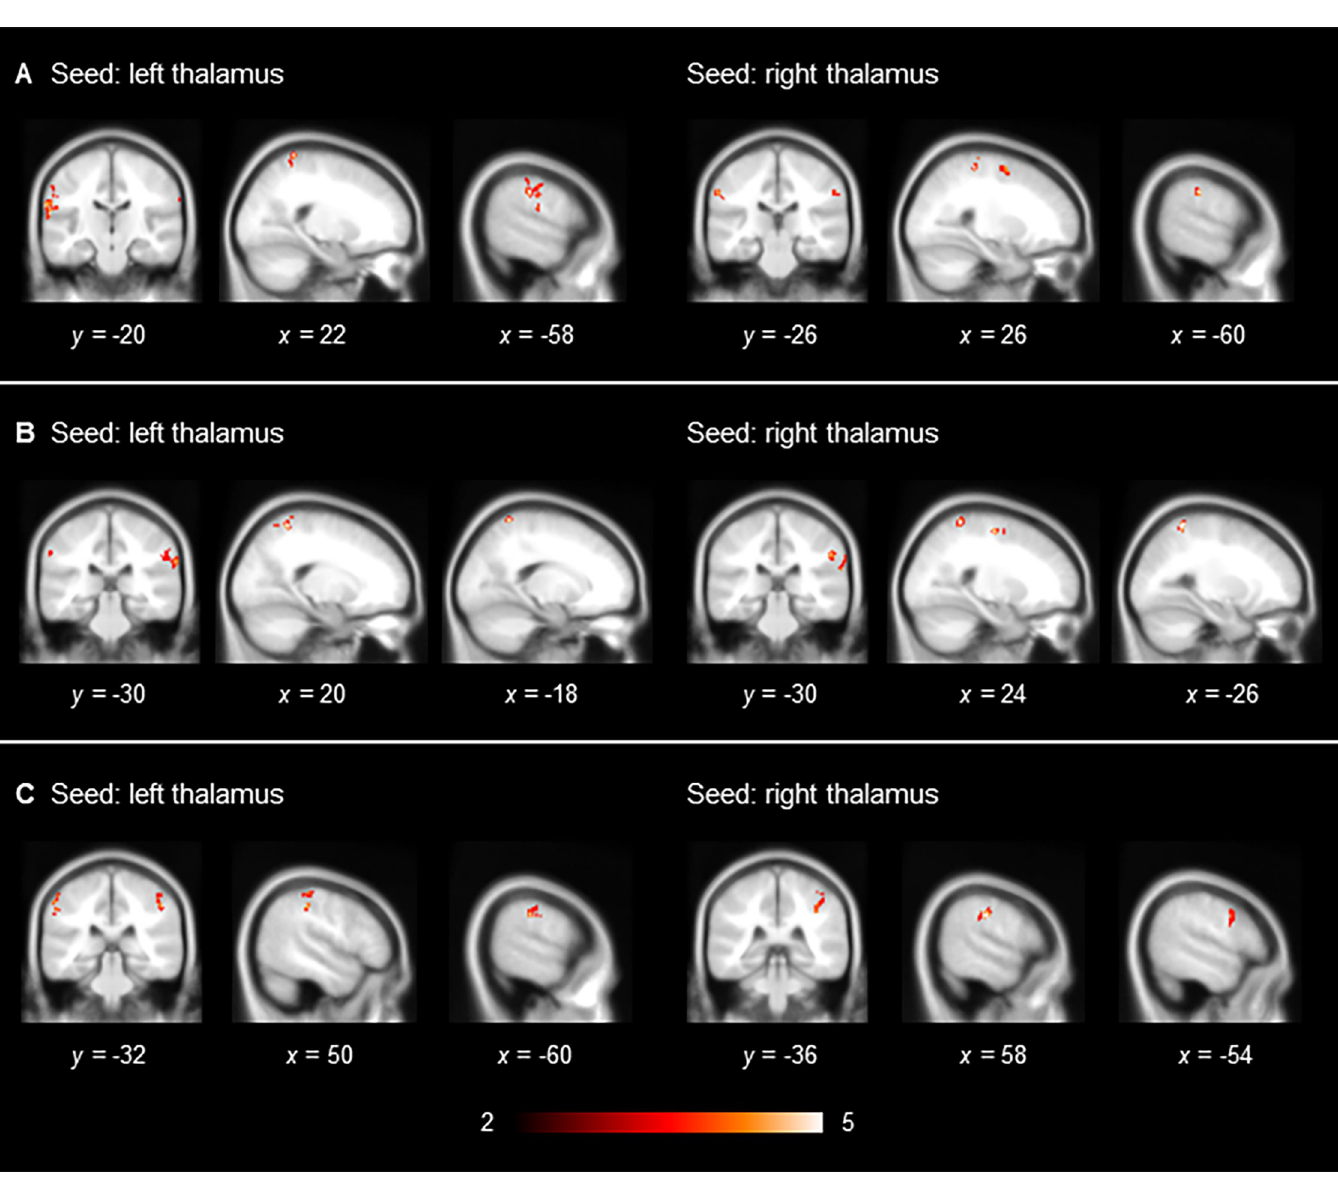
Fig 1. Significant increase in thalamic functional connectivity in adult cannabis non-users with a childhood diagnosis of ADHD compared with their counterparts who were cannabis users. (A) Scrubbing (+), global signal regression (+); (B) scrubbing ( − ), global signal regression (+), and (C) scrubbing ( − ), global signal regression ( − ). Results are displayed at a family-wise error-corrected cluster-defining threshold of p <